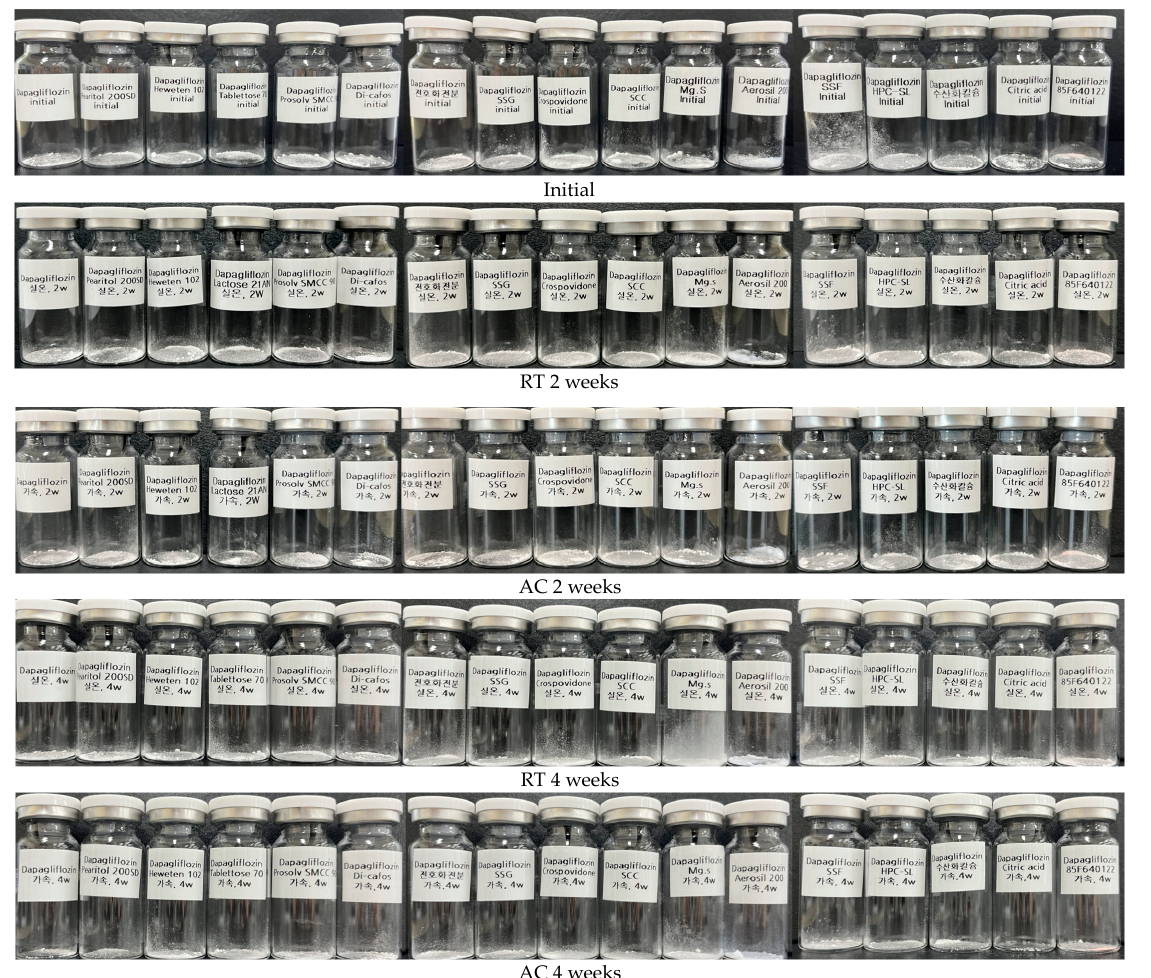
Figure 6. Appearance of compatibility test between sitagliptin phosphate monohydrate and various excipients; RT, room temperature storage condition; AC, accelerated storage condition.